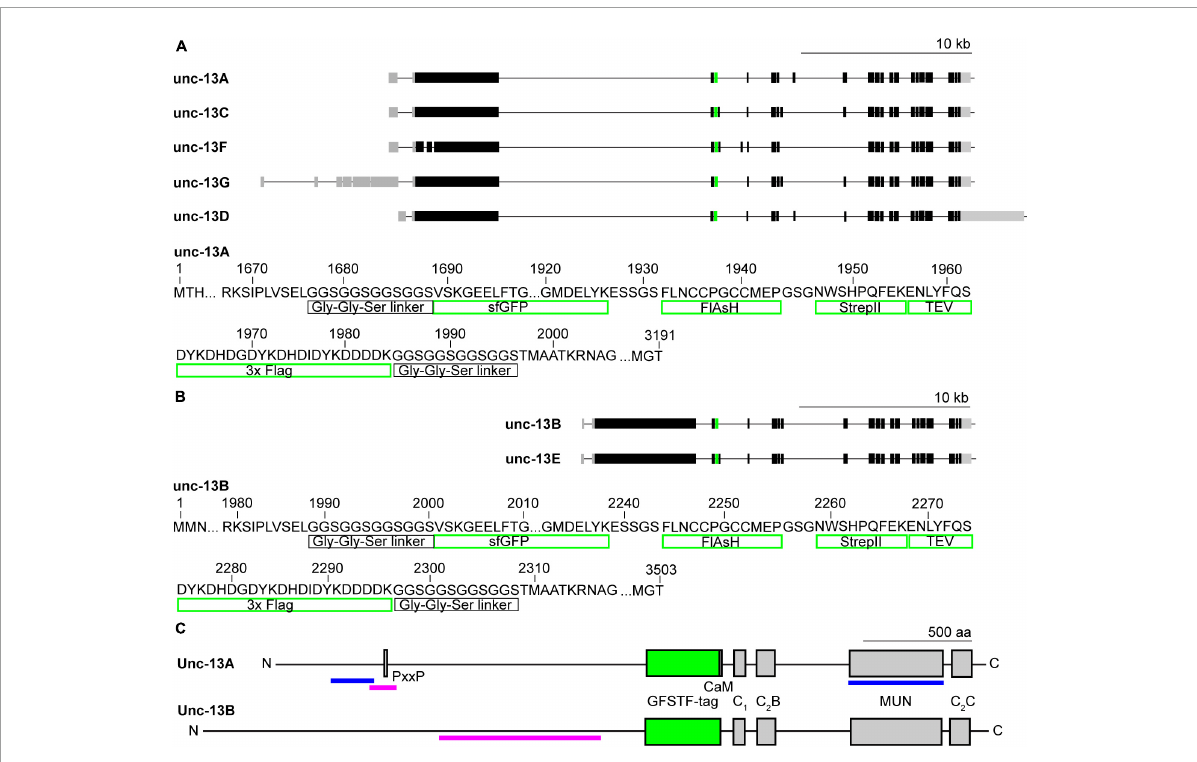
FIGURE1 Endogenous tagging of unc-13 in Drosophila melanogaster . (A,B) Genetic map of unc-13 in Drosophila with the five annotated transcripts A, C, F, G, and D (A) and the two annotated transcripts B and E (B) . Black boxes indicate exons, gray boxes introns and green boxes mark the insertion site of the EGFP-FlAsH-StrepII-TEV-3xFlag (GFSTF)-tag located in a coding intron. Lower panels show amino acids of the Unc-13A and Unc-13B fly protein illustrating the specific elements the GFSTF-tag consists of. (C) Schematic illustration of Unc-13A and Unc-13B domains: CaM- (Calmodulin), C 1 -, C 2 B-, C 2 C-, and MUN-domain and the PxxP-motif. Green box marks GFSTF-tag, magenta bars indicate epitopes of Unc-13A and Unc-13B antibodies (Böhme et al., 2016) and blue bars of N- and C-term antibodies, respectively (Reddy-Alla et al., 2017).